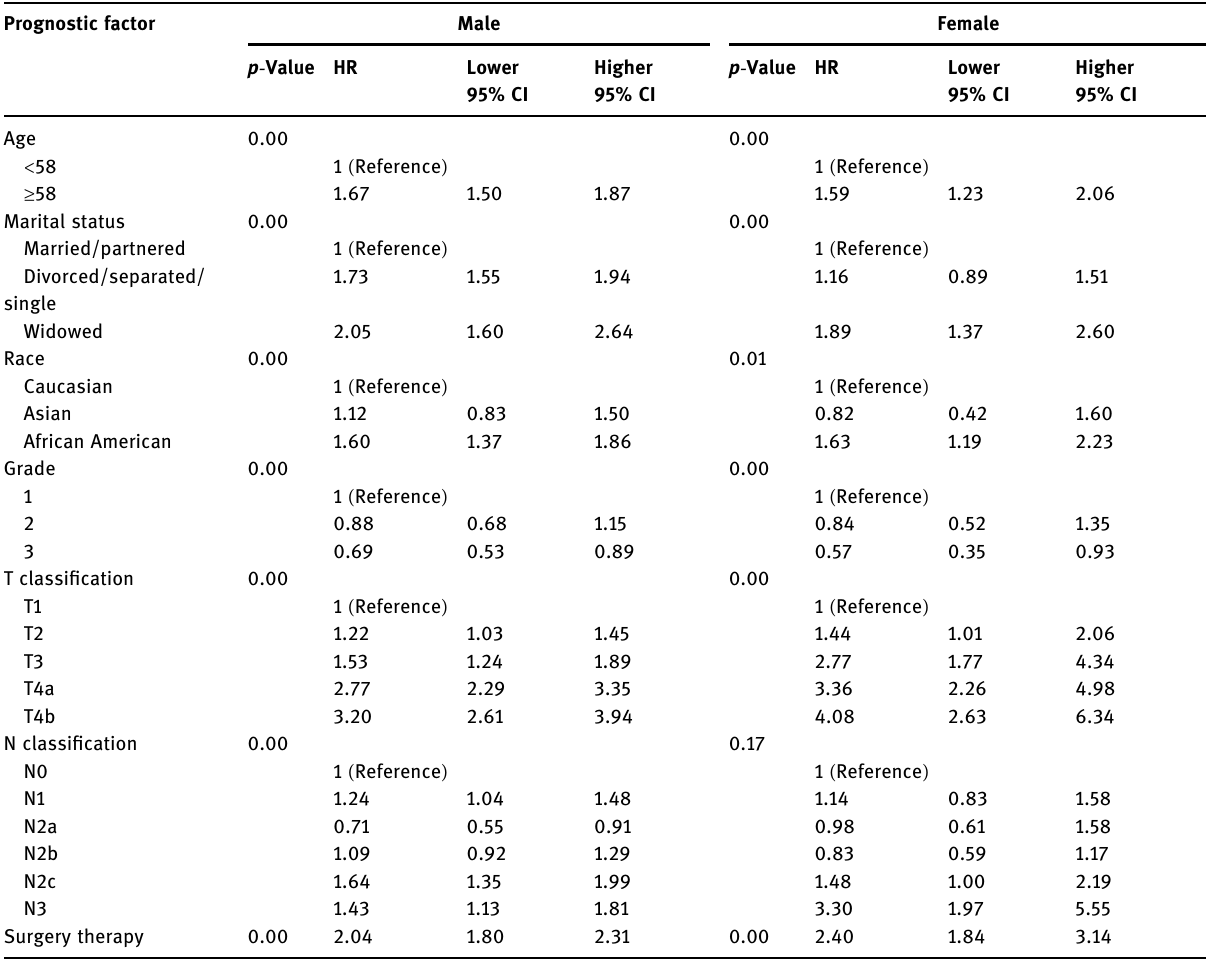
Table 3: Multivariable Cox proportional hazards analysis for CSS strati fi ed by gender Prognostic factor